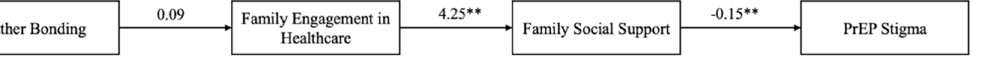
Figure 3. Pathways to PrEP stigma through father bonding ( n = 245). Note: standardized path coefficients presented. ** p < 0.01.